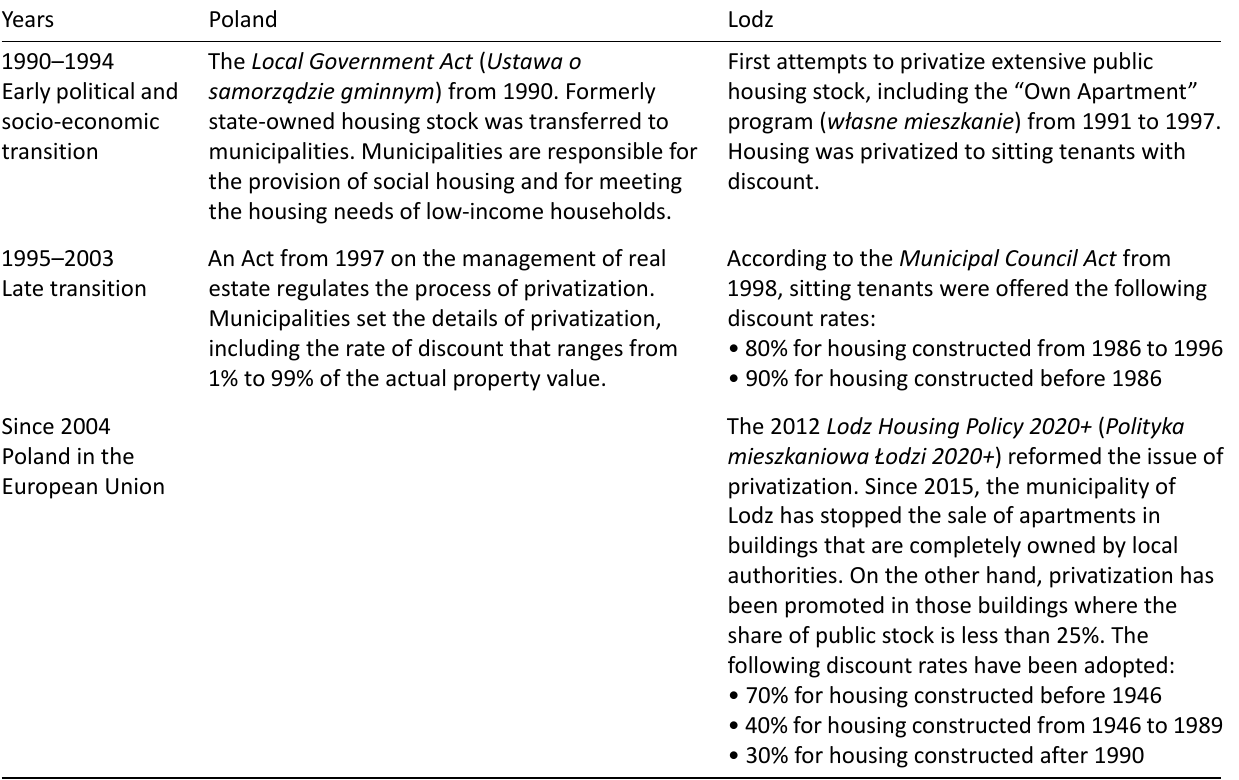
Table 1. Public housing related policies and regulations adopted in Poland and Lodz after